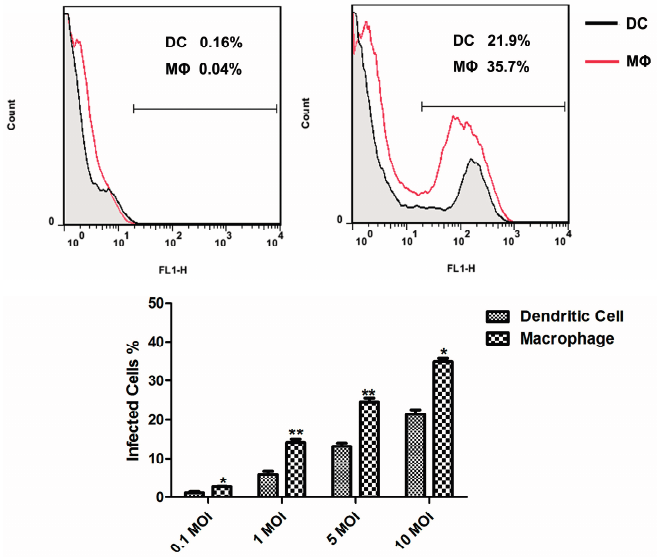
Figure 2. Infection of murine splenic M Φ s and DCs with rBCG-GFP. The percentage of dendritic cells and macrophages infected by rBCG-GFP was determined. Data depicted represent the mean values ± SEM. Statistical significance was determined by a Student’s t -test ( * p < 0.05, ** p <